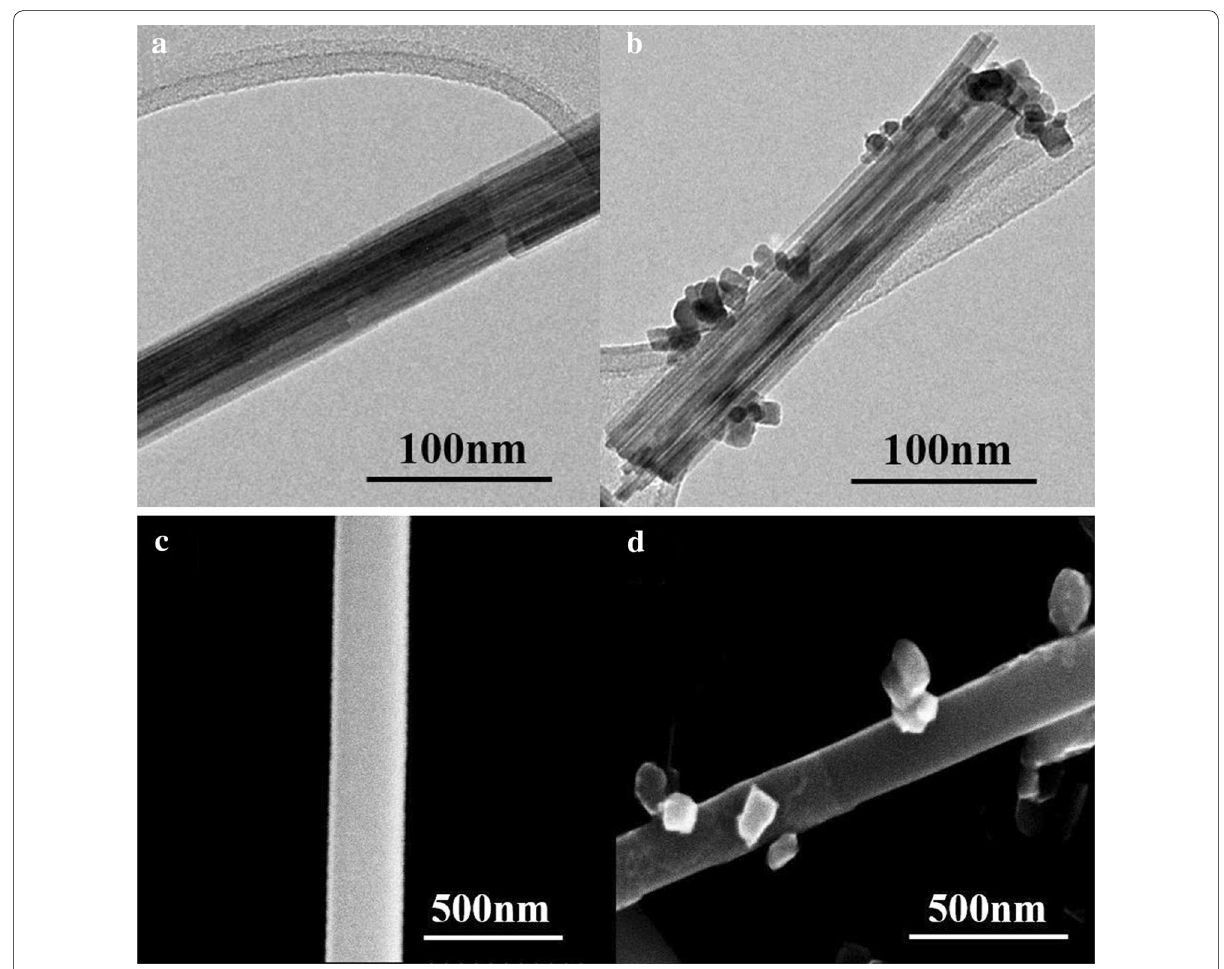
Fig. 1 Low‑magnification TEM images: a pristine and b In 2 O 3 NPs‑decorated WO 3 NRs and SEM images: c pristine and d WO 3 NPs‑decorated In 2 O 3